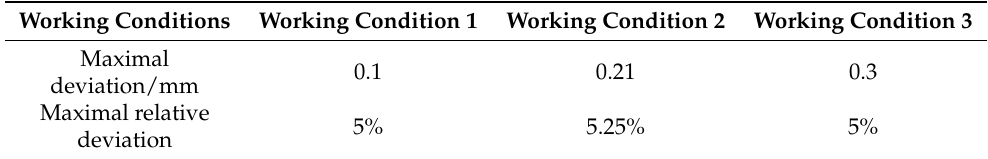
Table 6. Control deviation of the adaptive PID control system based on a neural